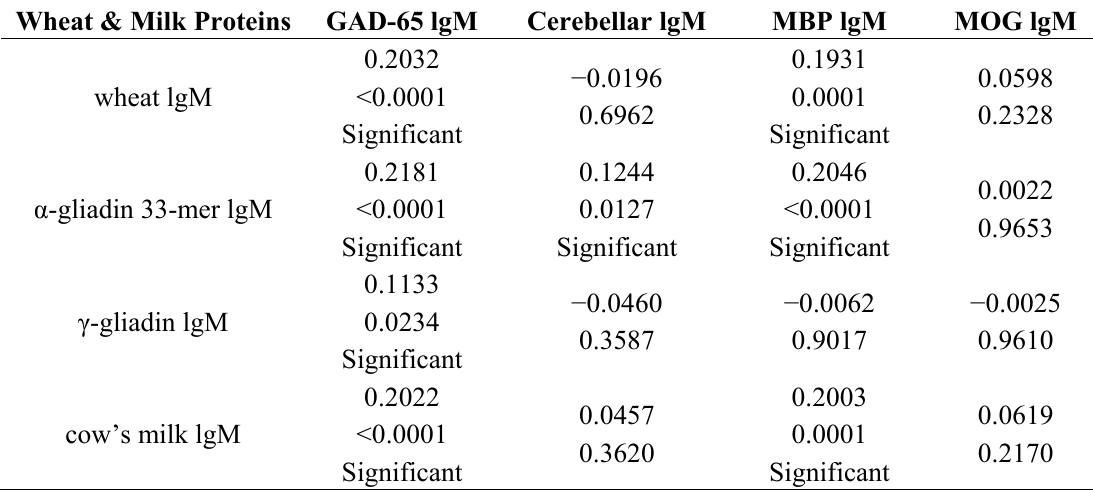
Table 3. Results of the simple linear regression between lgM isotypes of food proteins and the brain proteins. The first number in each cell presents corresponding Pearson’s correlation coefficient and the second number presents its p -value. Small p -value (less than 0.05) indicates statistical significance. Note that R 2 values of these regressions are the squares of the Pearson’s correlation